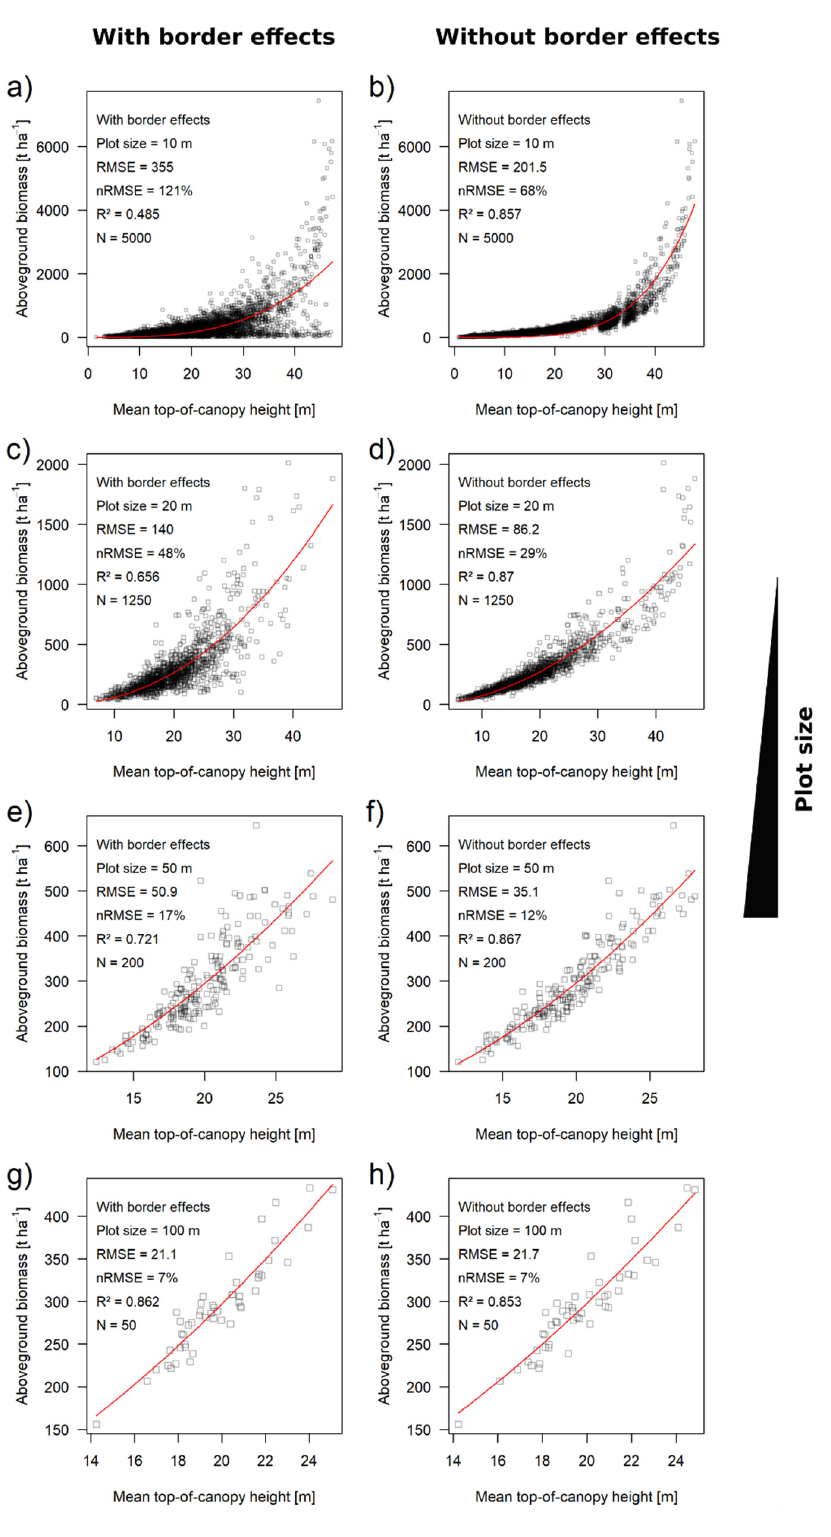
Figure 4. Height–biomass relationship for square-shaped plots of different sizes. The scatterplots show the aboveground biomass (AGB) plotted over the mean top-of-canopy height (TCH derived from simulated canopy height models). The red lines represent the best-fitting regression models. The left-hand side shows the normal conditions with border effects ( a , c , e , g ). The right-hand side shows the relationships derived from the data with the border effects switched off, using periodic boundaries ( b , d , f , h ).